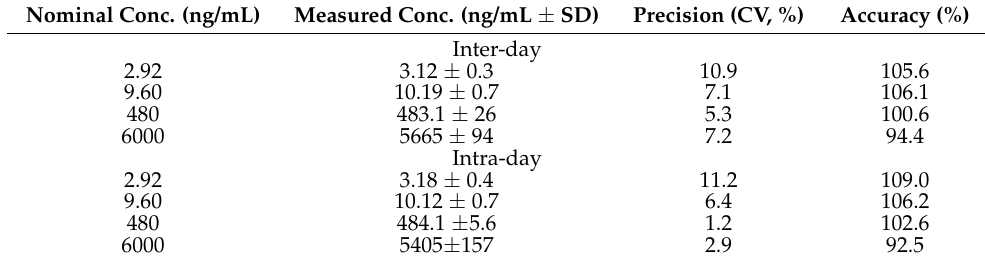
Table 2. Intra- and inter-day precision and accuracy of DFX in humans at LLOQ, LQC, MQC and HQC concentrations (n = 5).